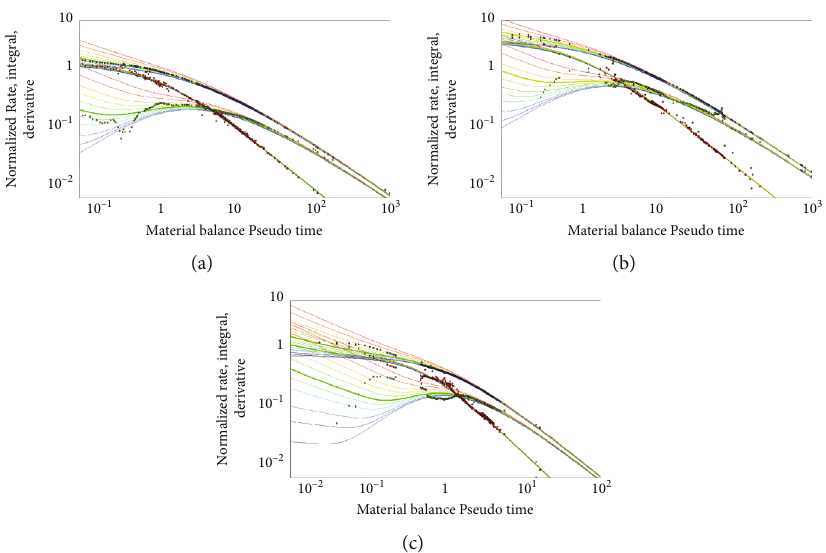
Figure 8: Fitting of Blasingame method type curve and production data: (a) L2-3, (b) Y2-8, and (c) Y4-5.